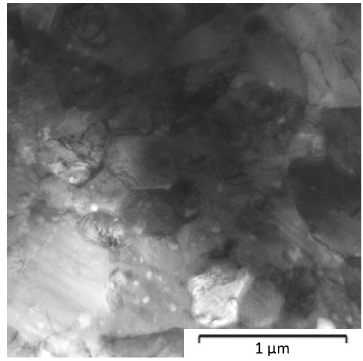
Figure 7. Microstructure of Zn-1Mg alloy compacted from mechanically milled powder (1200 RPM, 60 min) by SPS–TEM.